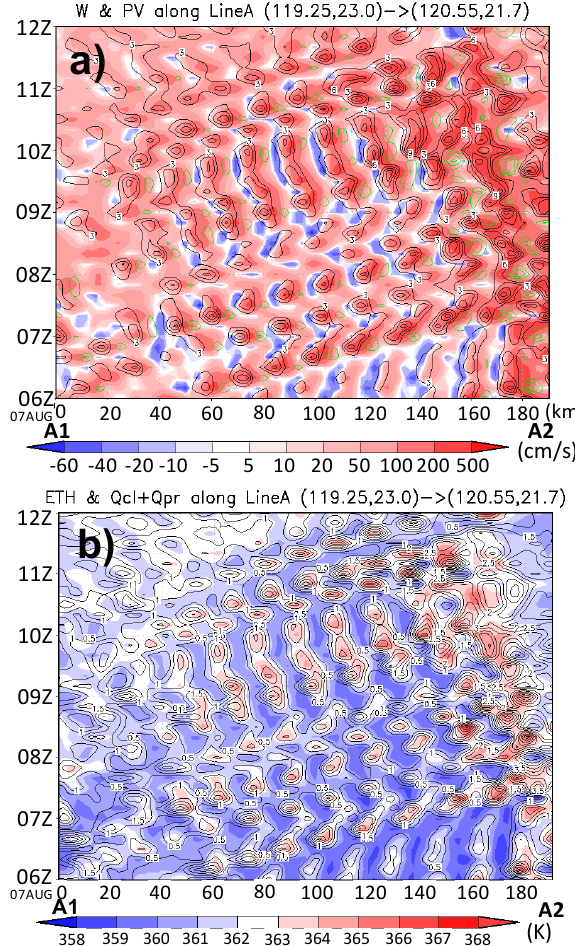
Fig. 9. Simulated results of the temporal variation of along cross- section A1–A2 in (b) from 06:00UTC to 12:00UTC 7 August. (a) Vertical velocity fields (colored shades: positive in red and negative in blue) and potential vorticity (contours: positive in black and neg- ative in green, interval: 2PVU) (b) Same as (a) but for theata-e and total precipitation mixing